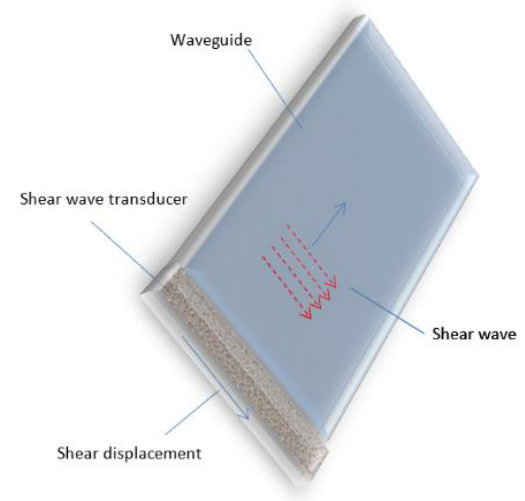
Figure 6. Excitation of the shear-horizontal wave in a rectangular waveguide.